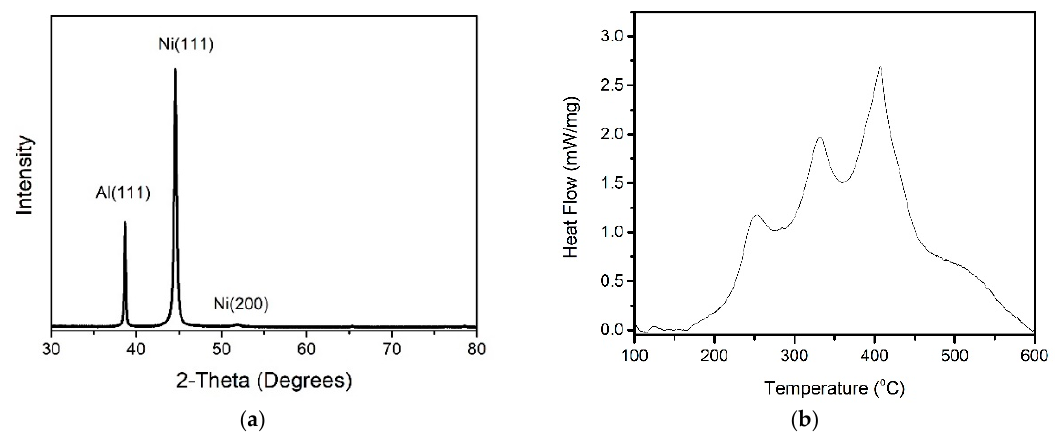
Figure 2. SEM images of ( a ) the total Ni/Al RMF; ( b ) the bilayer thickness of the Ni/Al RMF (white is Ni and grey is Al).